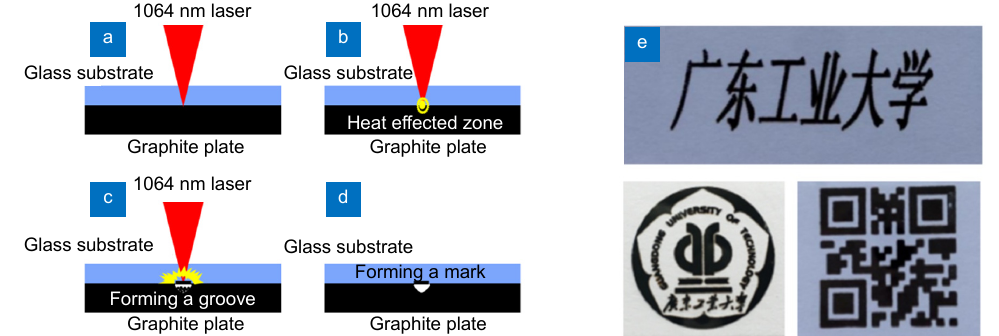
Fig. 4 | ( a – d ) The physical process of black color laser patterning of glass substrates. ( e ) Black laser pattern of glass substrate. Figure reproduced from: (a)–(d) ref. 50 , Optical Society of America.